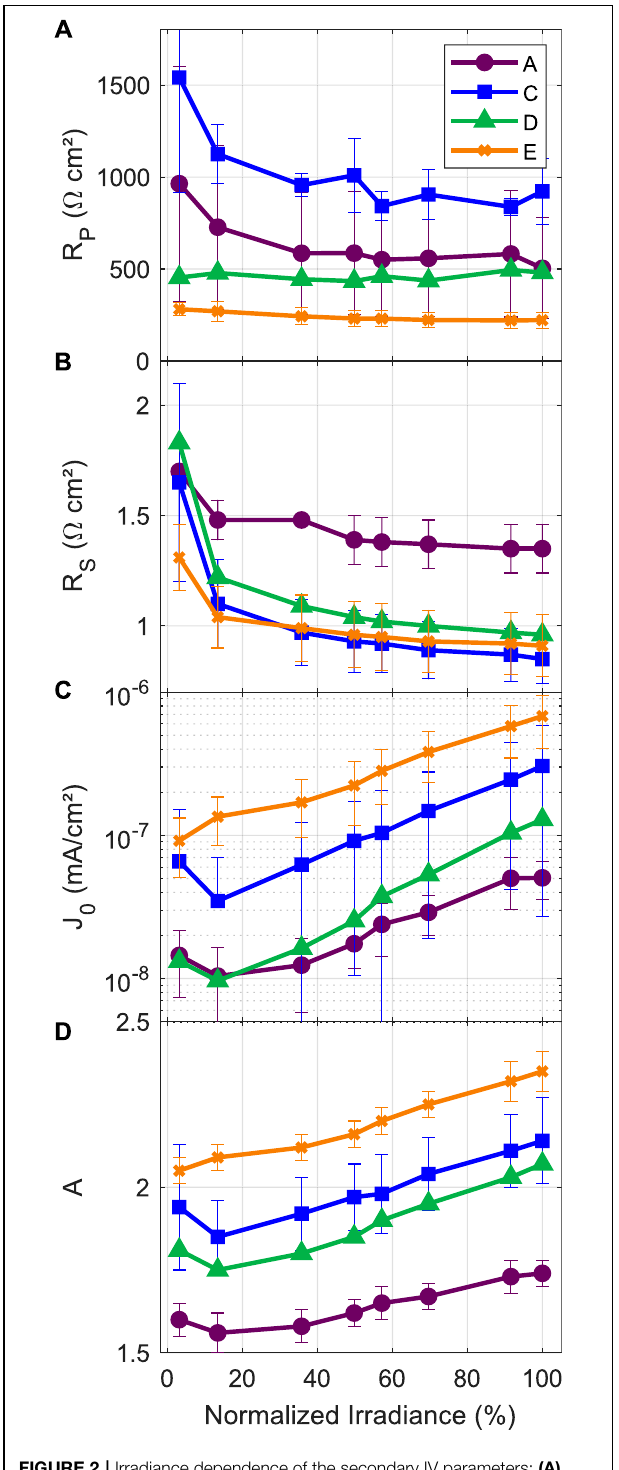
FIGURE 2 | Irradiance dependence of the secondary IV parameters: (A) parallel resistance, (B) series resistance, (C) saturation current density, (D) ideality factor. For each cell type, mean values (symbols) and standard deviations (error bars) are